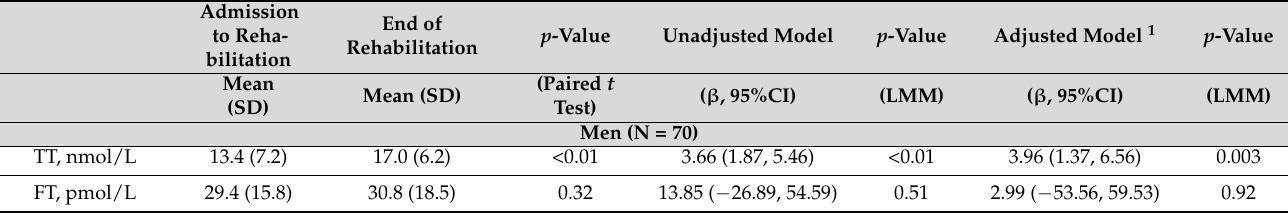
Table 3. Longitudinal changes in